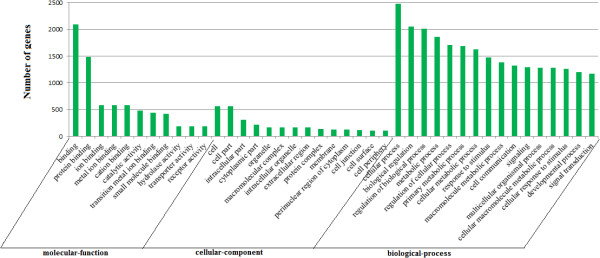
Partial gene ontology (GO) classification annotated for predicted target genes of 93 differentially expressed miRNAs. The figure shows partial GO enrichment for the predicted target genes in molecular function, cellular component and biological processes.